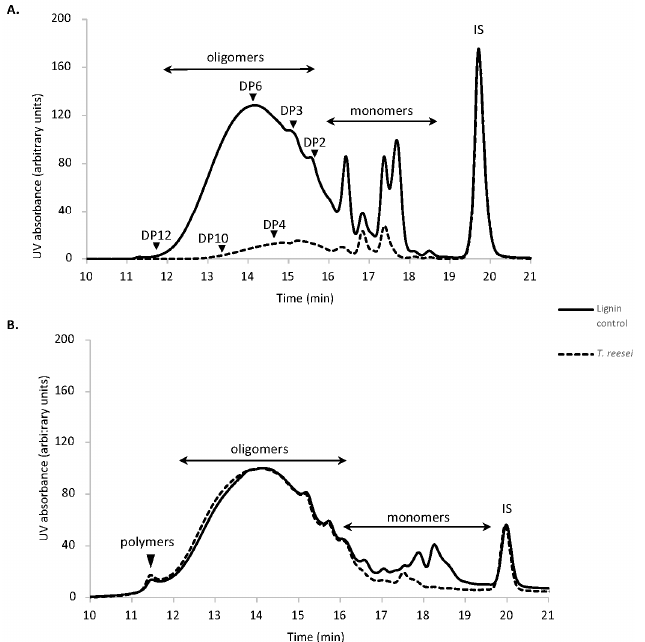
Figure 1. HPSEC analysis of residual lignin substrate. ( A ) water-soluble residual lignin fraction and ( B ) water insoluble residual lignin fraction. HPLC was performed on the ethyl acetate extracts of the culture supernatants and pellets recovered from soda lignin after 14-day incubation with T. reesei ; chromatograms normalized on IS. Eluent tetrahydrofuran (THF), 1 mL/min; detection at 280 nm; 100 Å PL-gel column (Polymer Laboratories, 5 µm, 600 mm × 7.5 mm). The lignin control was dissolved in the culture media in the absence of fungi and incubated under the same conditions. DP: degree of polymerization, IS: internal standard is toluene.